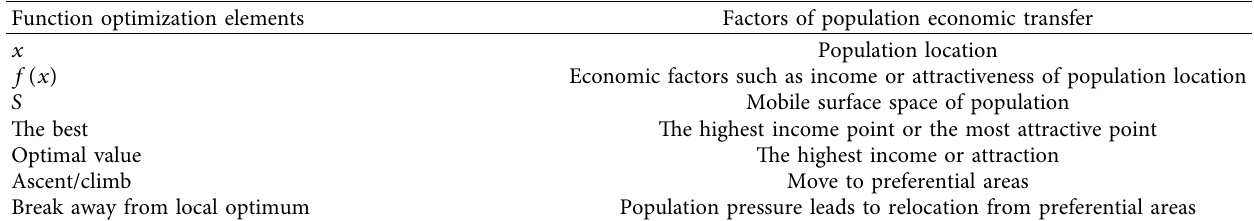
Table 1: Comparison of function optimization factors and population economic